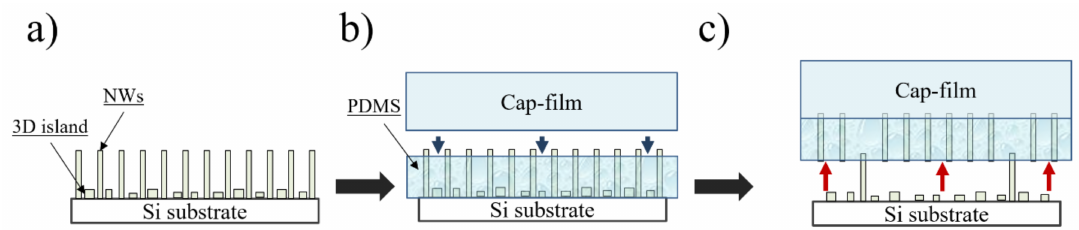
Figure 1. Schematic representation of the ( a ) nanowire (NW) as-grown array on Si substrate, ( b ) encapsulation of NW array into polydimethylsiloxane (PDMS) membrane and cap-film covering, ( c ) the NW / PDMS membrane